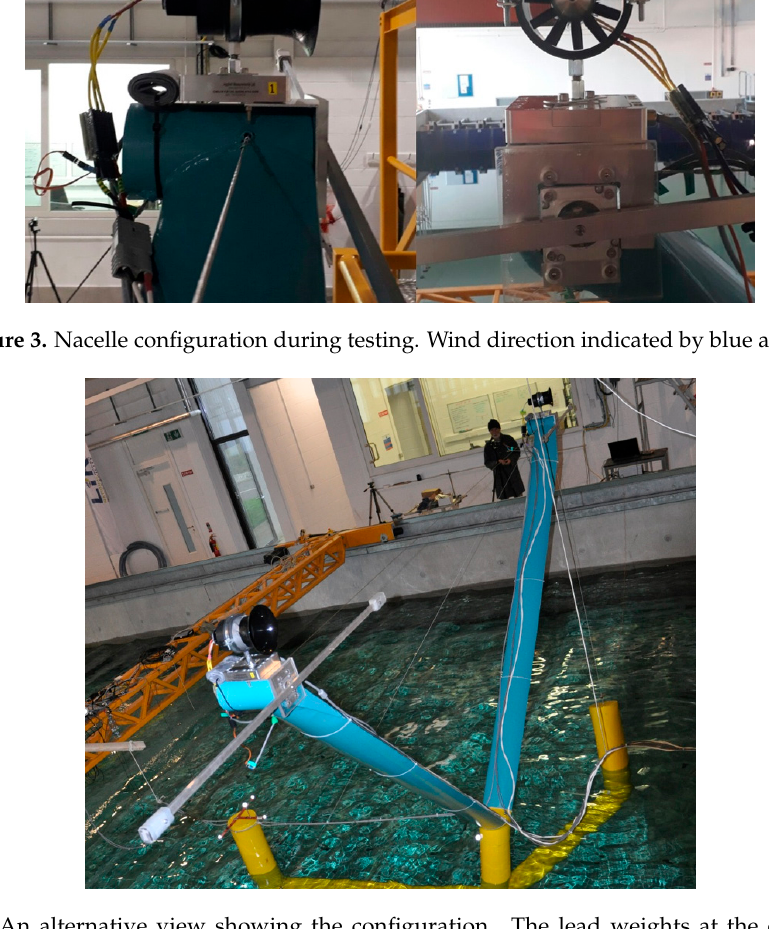
Figure 4. An alternative view showing the configuration. The lead weights at the end of each aluminium rotating beam can be seen. This configuration was used for all tests presented in this